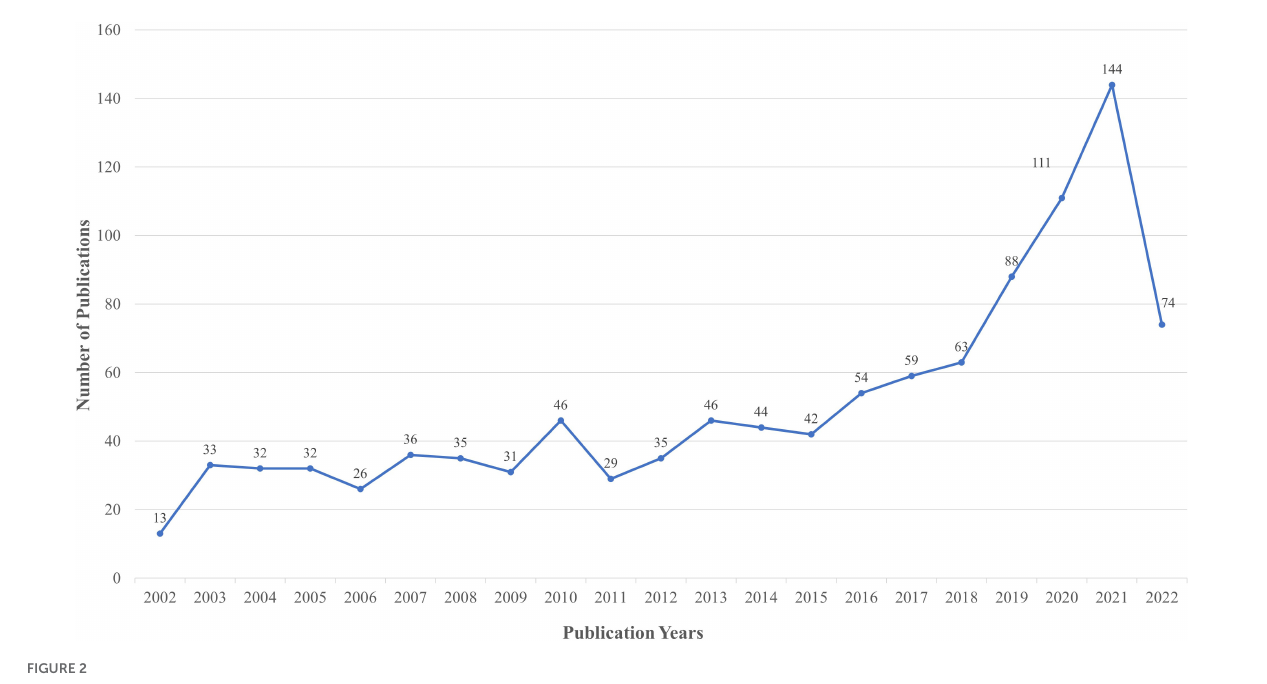
FIGURE2 Trend of the number of literatures of SIMD in the past 20 years.